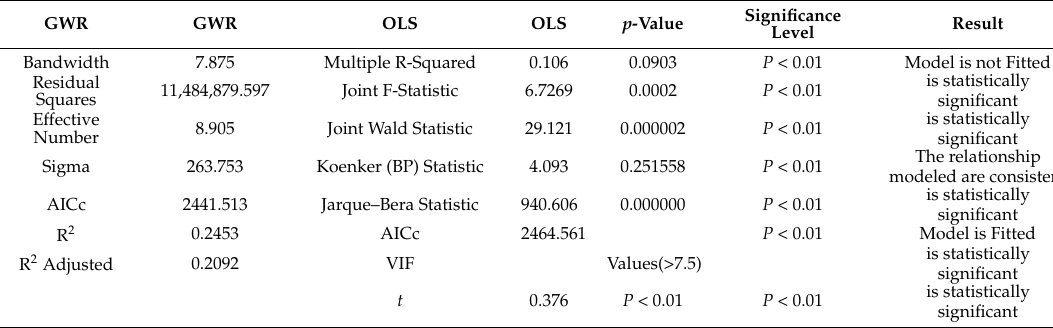
Table 9. Results of OLS and GWR models.